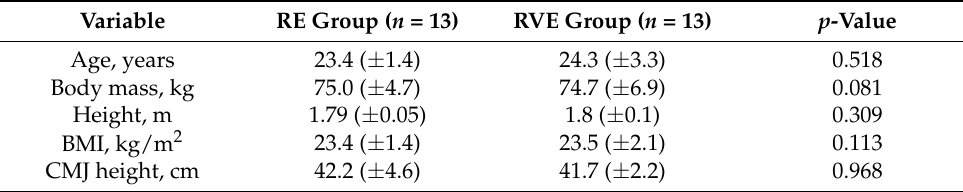
Table 1. Baseline characteristics of the participating